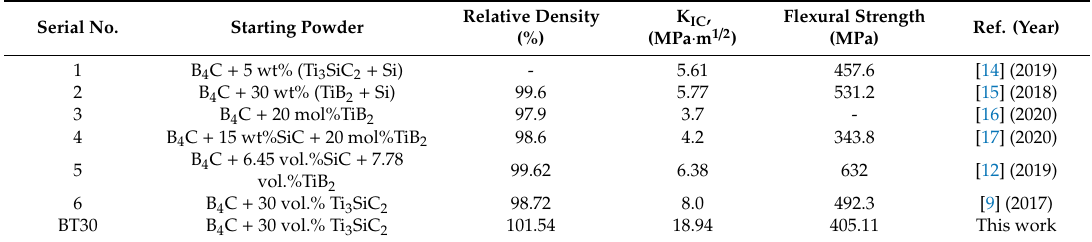
Table 3. Comparison of the properties of the B 4 C–TiB 2 composite ceramics reported in recent years. Serial No.